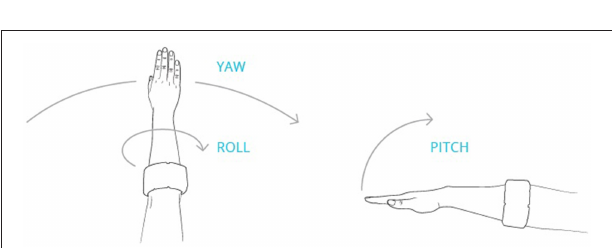
FIGURE 4 | Illustration of how pitch, yaw and roll are measured in relation to the orientation of the Myo Armband. Pitch, yaw, and roll are orthogonally independent; thus pitch will reflect the elevation of the arm, regardless of the orientation of the hand, i.e., the hand does not need to remain palm down as shown in the sketch. (Source: http://developerblog.myo.